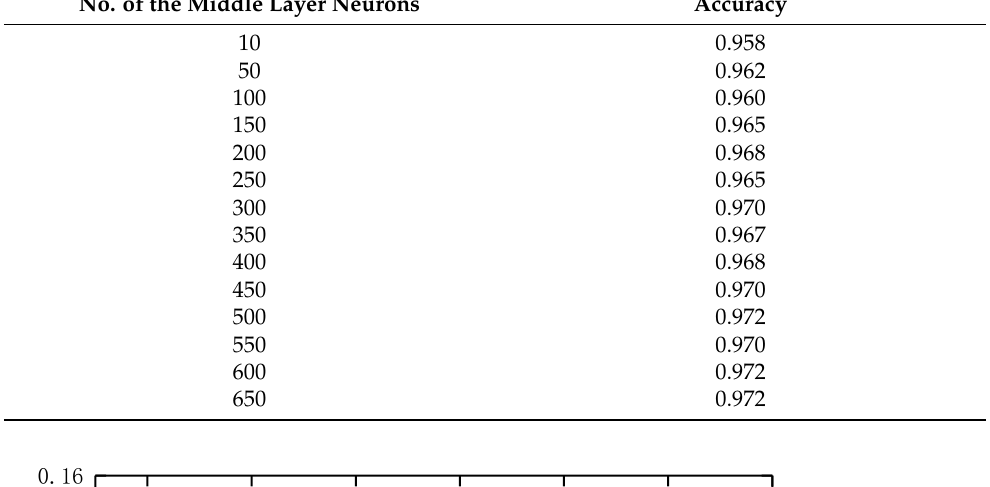
7 of 11 Figure 5. The accuracy variation of CNNs with the number of middle-layer neurons. Table 1. The accuracy variation with the number of middle-layer neurons.